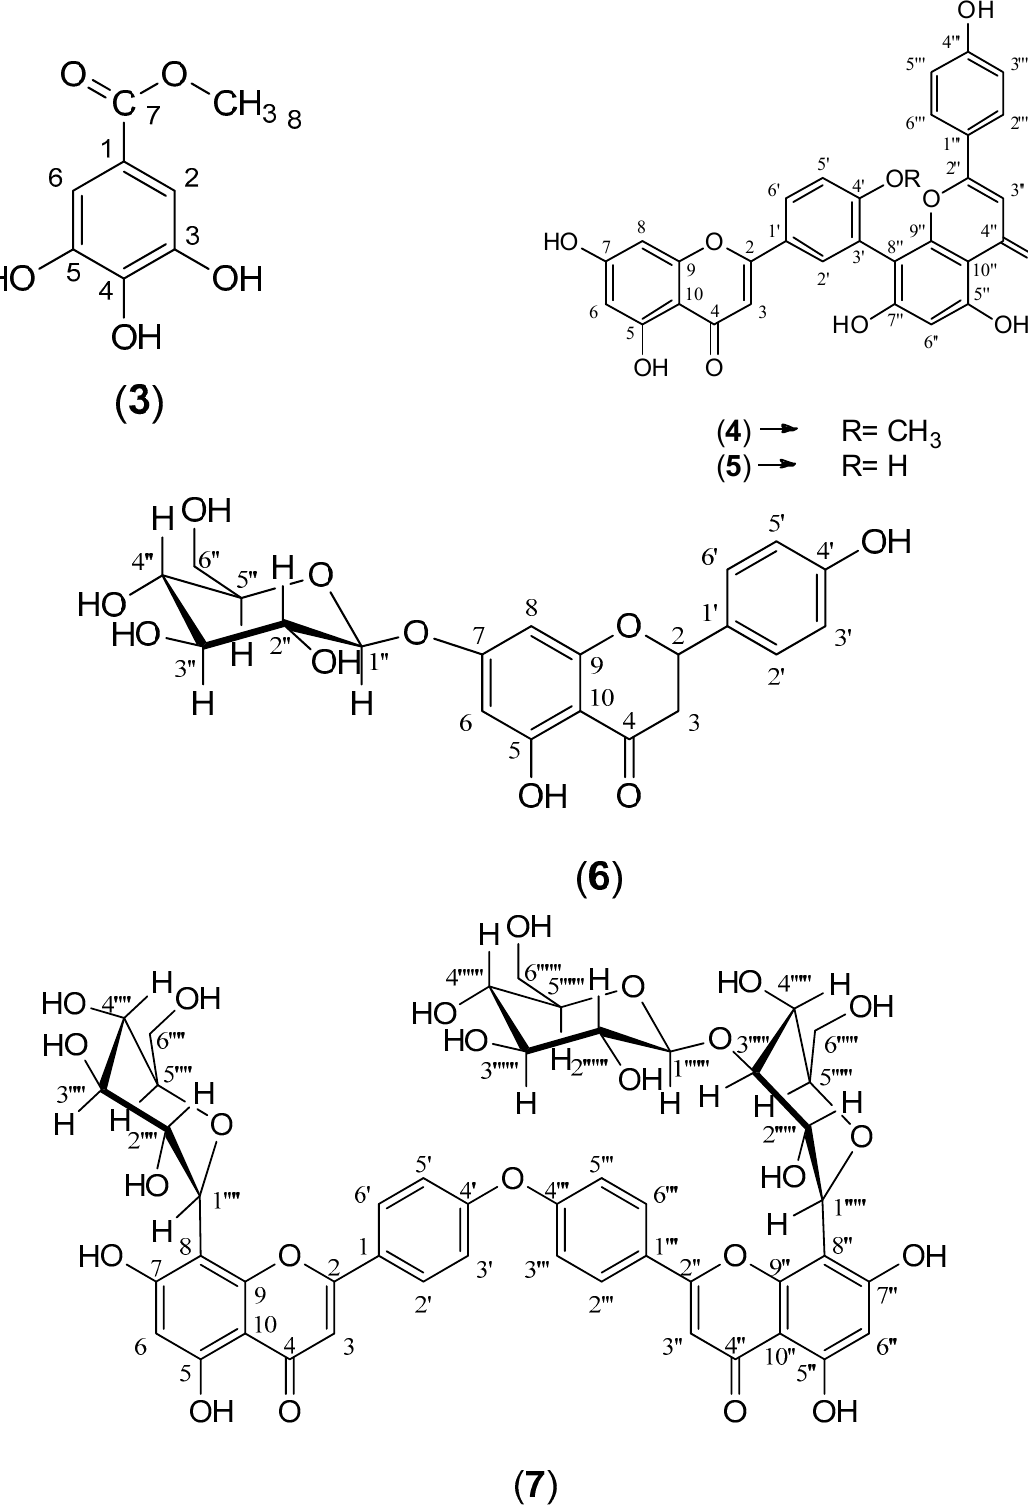
Figure 3. Structures of compounds ( 1 – 7 ) isolated from the ethyl acetate fraction of C. rumphii Miq. Identification of Compound ( 7 )